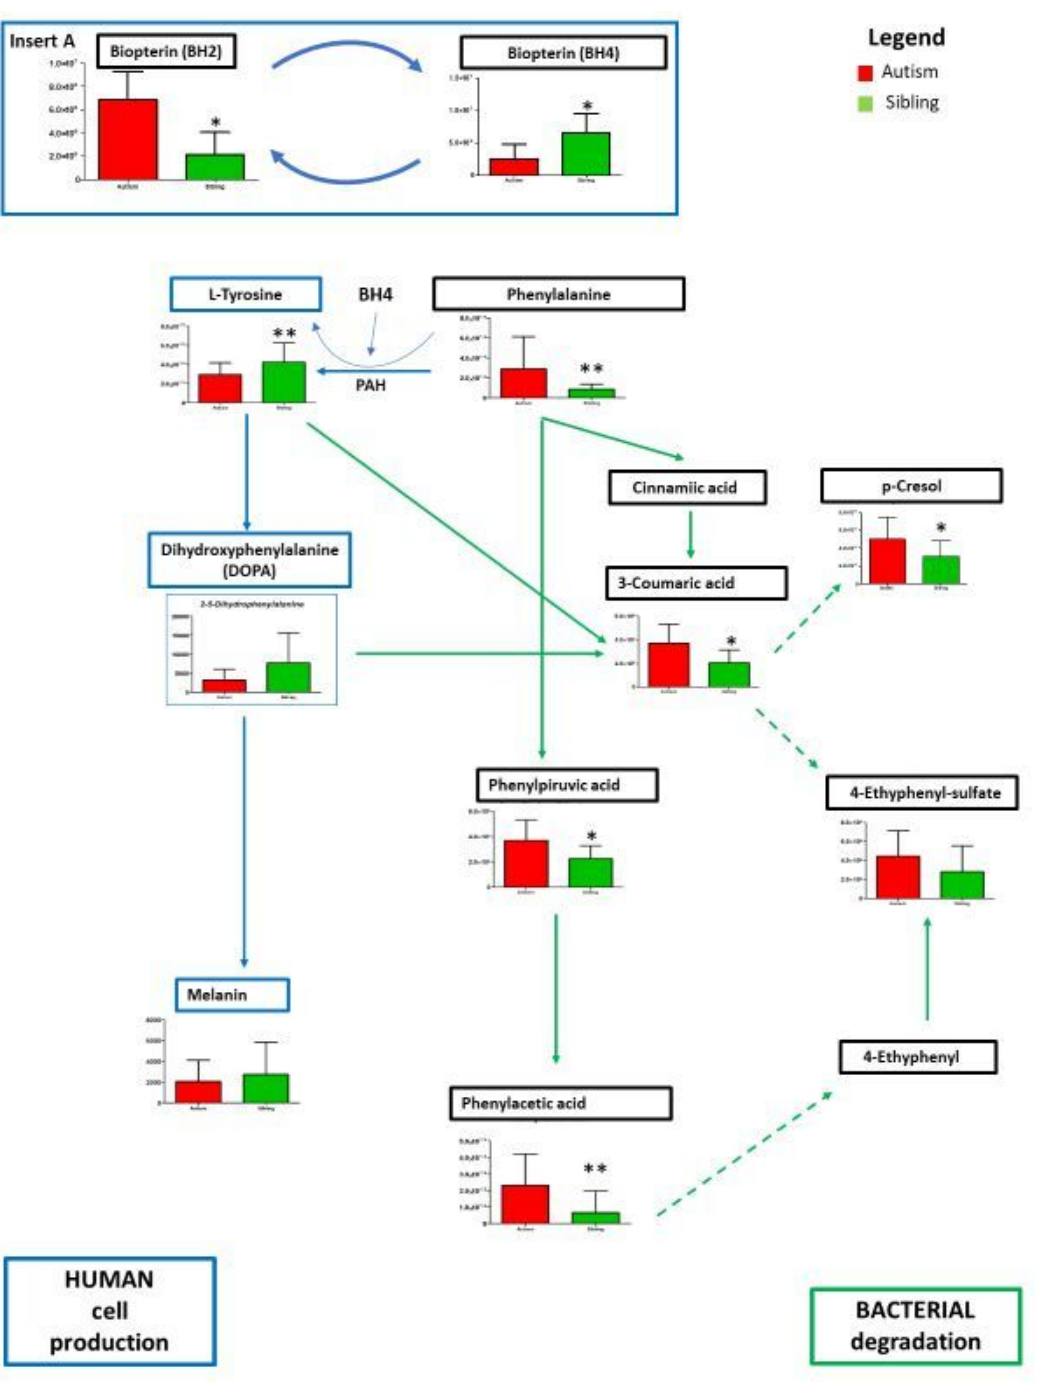
Figure 6. Intermediates of the phenylalanine/L-tyrosine pathway by human cells and gut bacteria, leading also to the formation of 4-ethylphenol sulfate (4-EPS) and p-cresol. are presented as the differences between autistic subjects in red and typically-developing siblings in green. The columns represent the mean ± SD (n = 14) of each metabolite concentration. * p < 0.05, ** p < 0.01, etabolites derived from bacterial degradation are boxed in green, metabolites from human cell production in blue. Solid lines represent established reactions, dotted lines represent presumed reactions taking place.